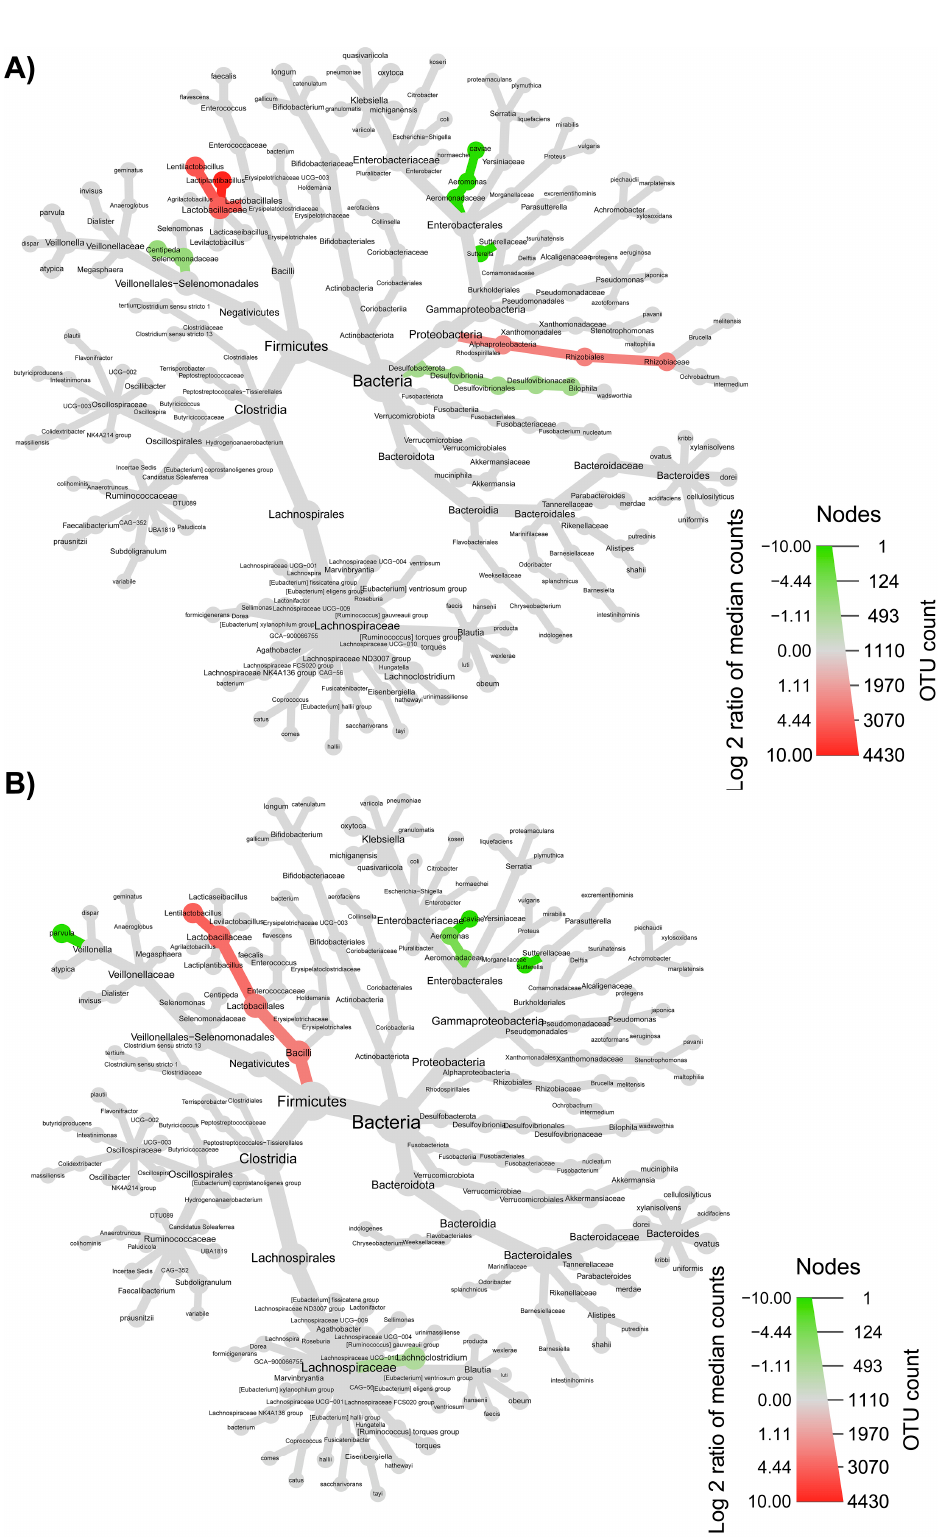
Figure 6. Microbial community taxonomic structure variations at different levels, before compared to after feeding with MOB ( A ), and before feeding against the end of wash out period ( B ). Node size denotes the rarefied ASV count, and colored nodes indicate a significant ( p < 0.05) fold change for a given taxon: green color means that the taxon is differentially abundant before the treatment, while red color indicates that the taxon is differentially abundant after feeding ( A ) or after wash out period ( B ). Color intensity is proportional to the fold change.